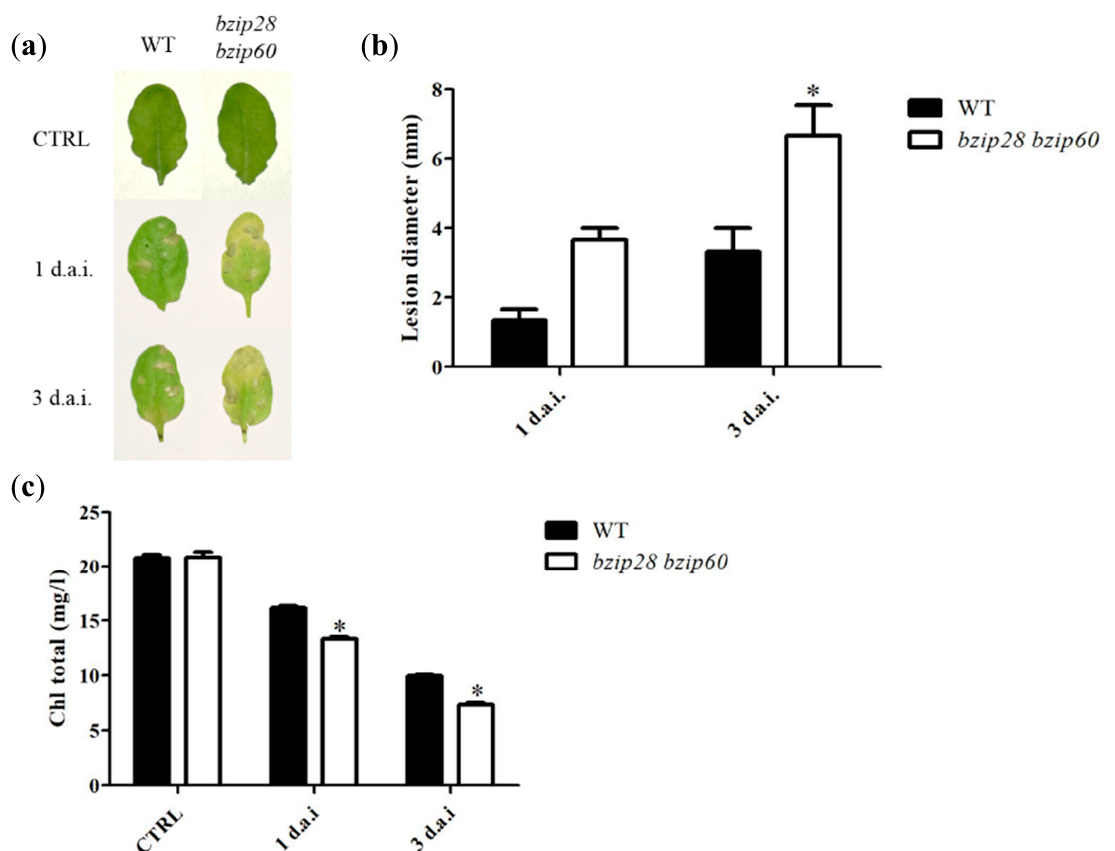
Figure 1. Phenotype ( a ), necrotic areas ( b ) and chlorophyll content ( c ) of WT and bzip28 bzip60 mutant Arabidopsis plants infected by D. gigantea. ( a ) WT and bzip28 bzip60 mutant plants were sprayed with a suspension of D. gigantea conidia (500,000 /mL). Leaves were collected 1 and 3 d.a.i. and subjected to optical image recording. ( b ) Diameter of necrotic lesions was measured after 1 and 3 d.a.i. on detached leaves inoculated with 5- µ L droplets of fungal conidia suspension. The results represent mean values ± SD ( n > 10). Statistical significance was attributed by Student’s test (* p < 0.05). ( c ) Leaves from WT and bzip28 bzip60 mutant plants treated as reported in ( a ) were extracted for determination of total chlorophyll, and the corresponding values determined (mg/L) as described in Section 2.3. The results represent mean values ± SD ( n > 10). Statistical significance was attributed by Student’s test (* p <